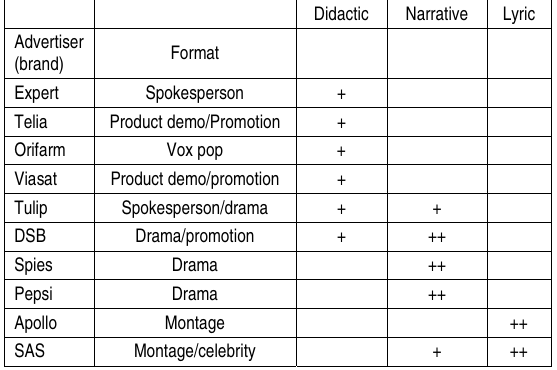
expected dominant experiential dimensions